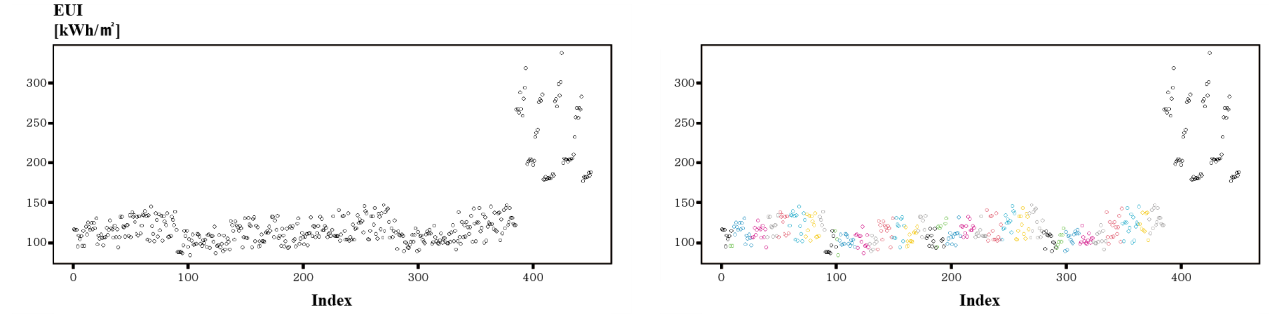
Figure 3. GMM clustering before ( left ) and after ( right ) PCA.